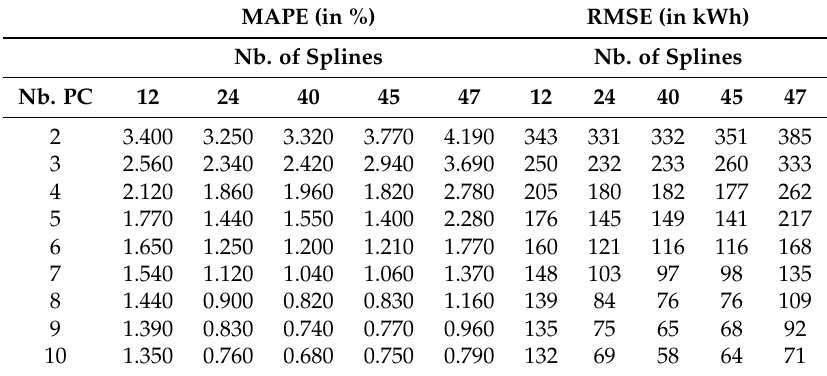
Table 7. RMSE and MAPE errors for splines smoothing load data reconstitution via FPCA as a function of the number of splines and the number of principal